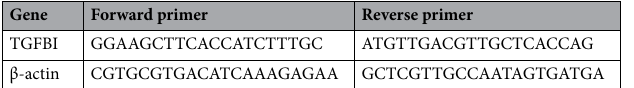
Table 1. Primer sequences used for quantitative RT-PCR.